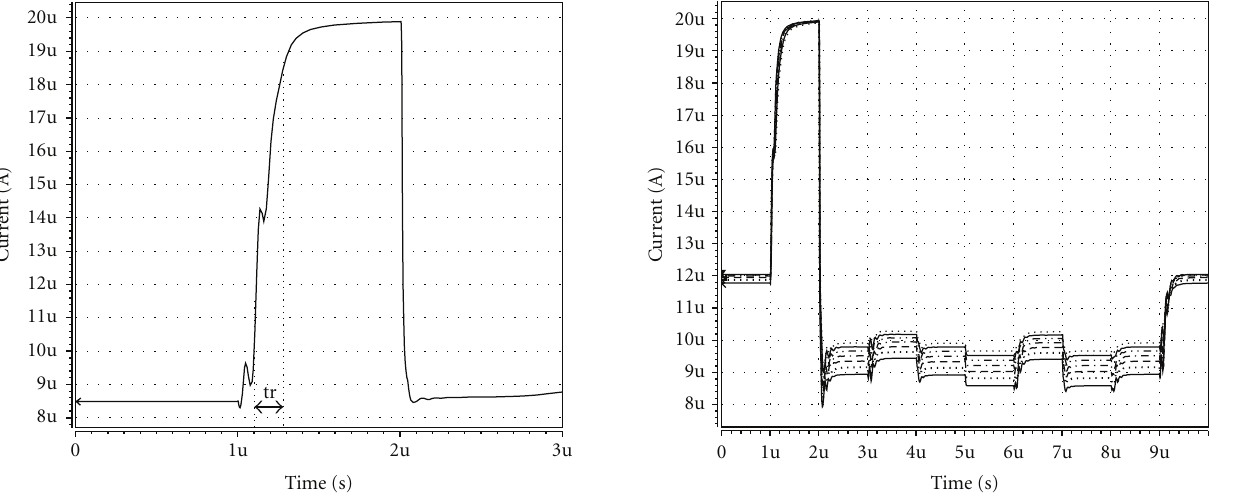
Figure 9: Time response for evaluate the rise time of the fuzzy classifier circuit.